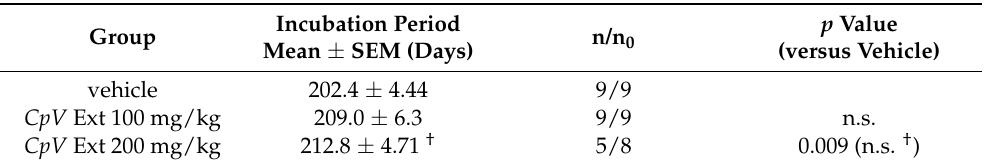
Table 1. The average incubation periods and the disease onset frequency of prion-infected mouse groups that received CpV extract 1 .